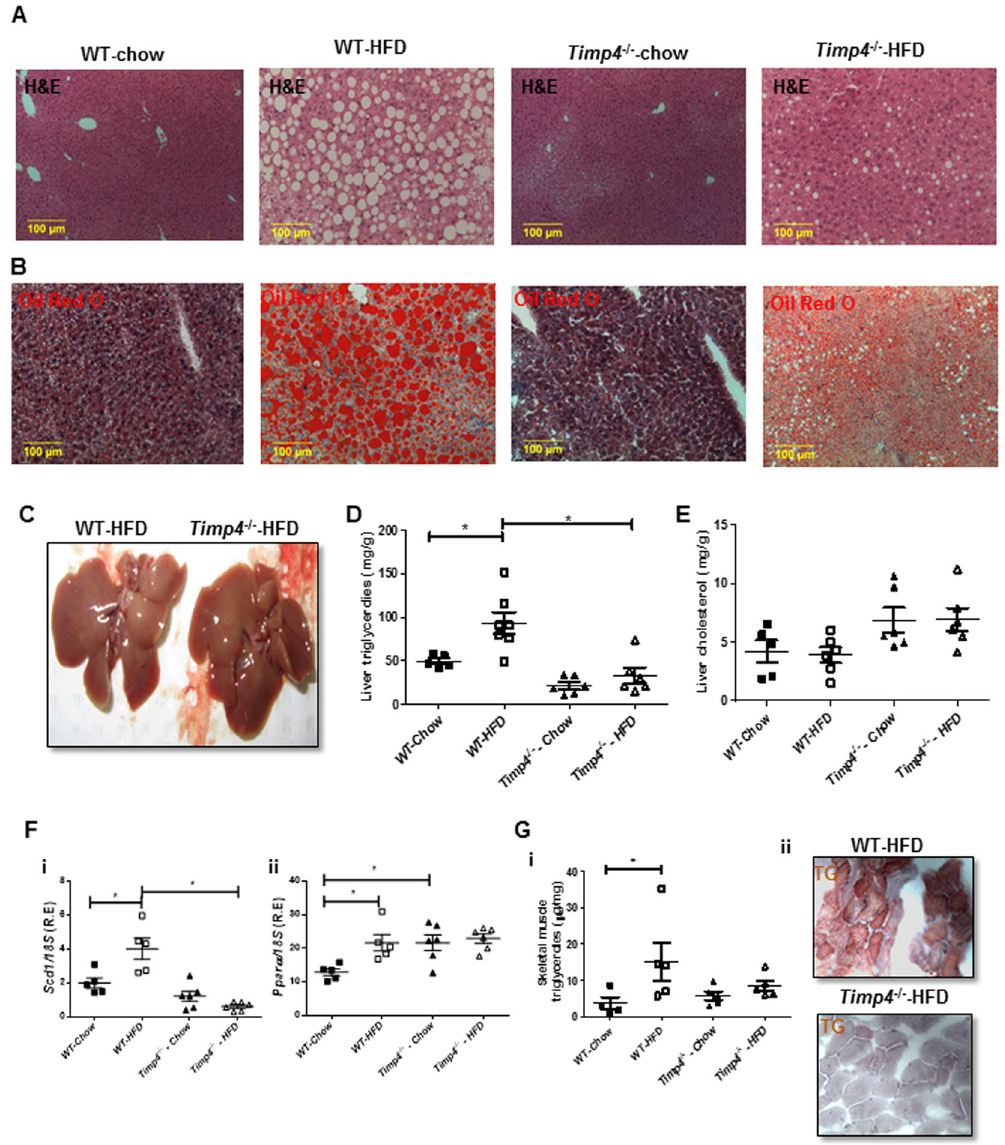
Figure 4. Timp4 gene deletion protects mice from HFD-induced hepatic steatosis. H and E staining ( A ) and Oil Red-O staining ( B ) of fixed liver after 12 -weeks of chow on high fat diet (HFD) in the indicated genotypes. Representative picture of livers WT-HFD and Timp4 − / − HFD mice ( C ). Liver TG content ( D ) and hepatic cholesterol content ( E ) in indicated groups. ( F ) mRNA expression of Scd1 (i) and Ppar α (ii) in the liver. ( G ) Skeletal muscle TG content (i) and fat deposition as indicated by Oil Red-O staining (ii) (400X). Averaged data are presented as mean ± S.E.M and analyzed by ANOVA. * Indicates significance (p <